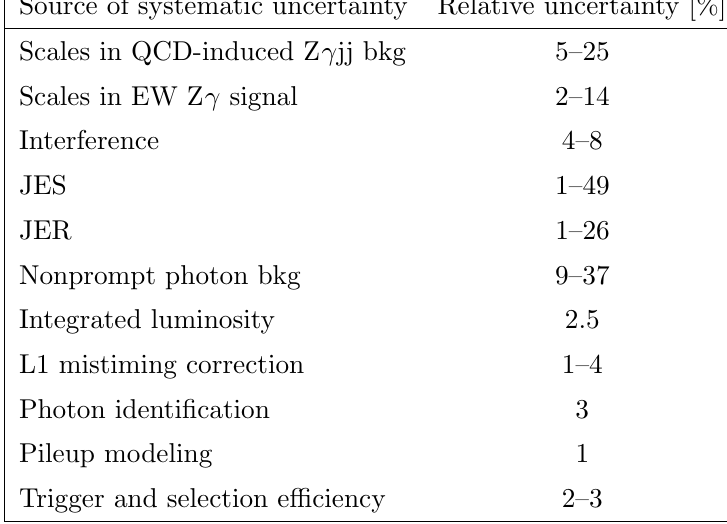
Table 2 . The pre-(cid:12)t systematic uncertainties in the measurement of the extracted signal. They are for signal or background (bkg) if the source is speci(cid:12)ed, or for both if the source is not